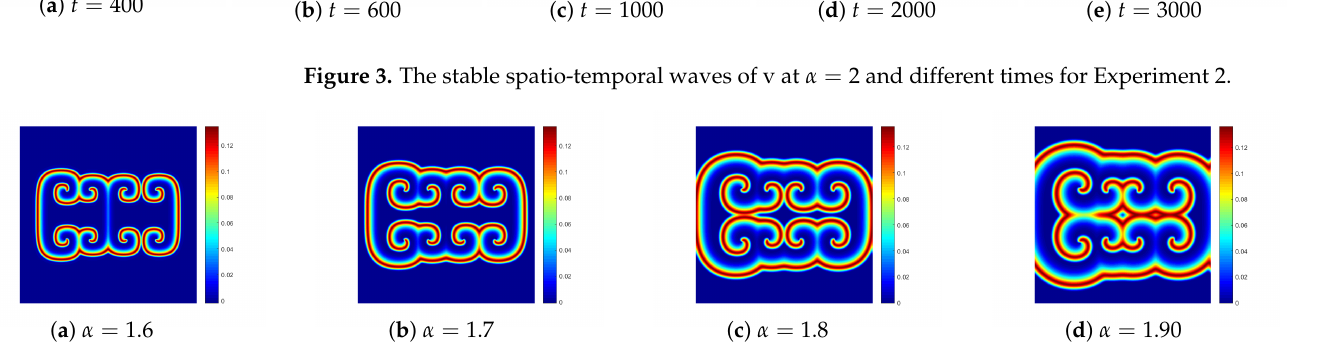
Figure 4. The stable spatio-temporal waves of v at t = 400 for Experiment 2.